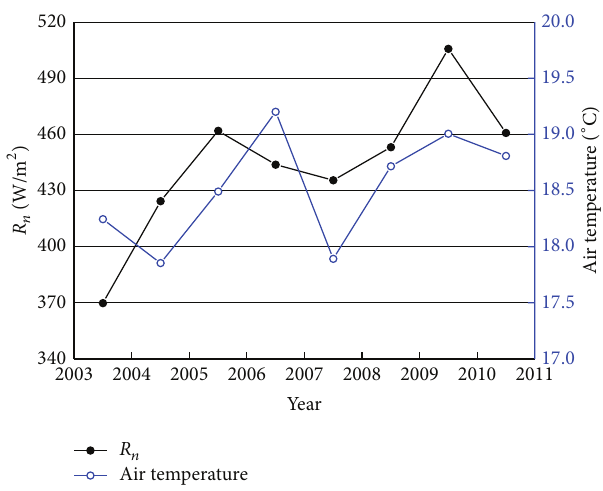
Figure 4: The variation trends of annually averaged air temperature and net radiation in Dongping Lake during 2003–2010 (open circle means air temperature, dot means net radiation).